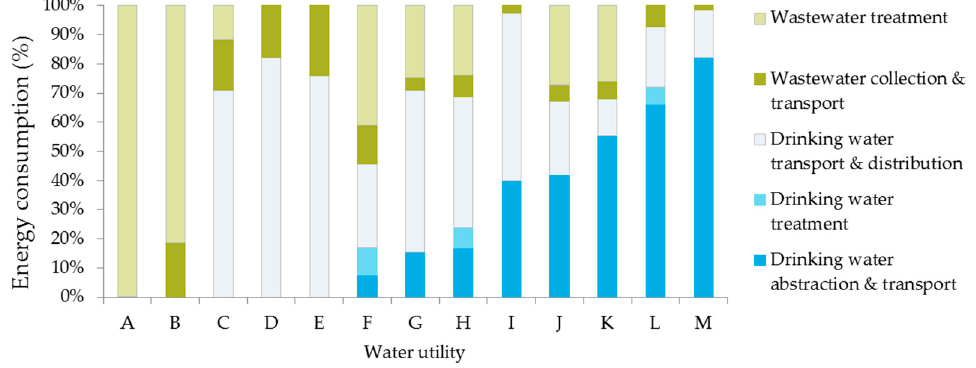
Figure 2. Relative energy consumption per UWS stage for the 13 water utilities participating in the Avaler+ project.